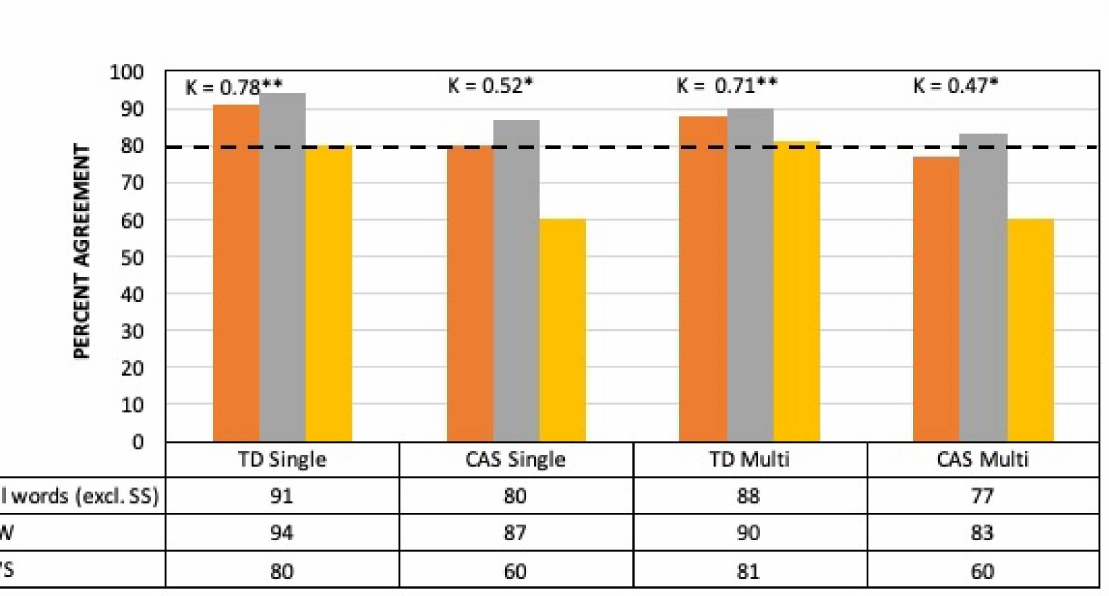
Figure 2. Percent agreement and Cohen’s kappa values for automated classification with single- vs. multiple-pronunciation HMM-based forced alignment compared with auditory perceptual judgment. TD = typically developing, CAS = childhood apraxia of speech, SS = strong–strong stress, SW = strong–weak stress, and WS = weak–strong stress, * = moderate effect, ** = substantial